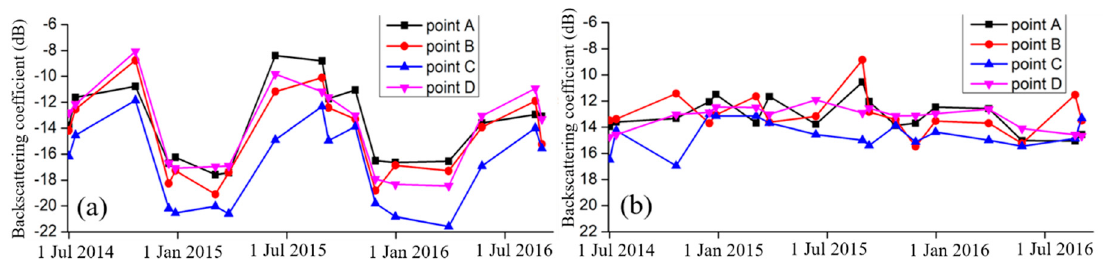
Figure 6. σ 0 variations for two different land cover types: ( a ) alpine meadow area and ( b ) alpine desert area.